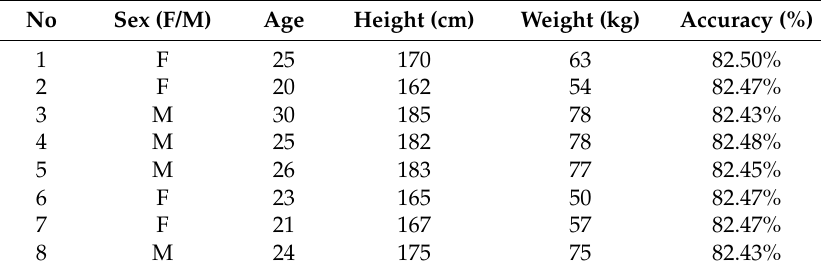
Table 11. Subjects profile and correct differentiation